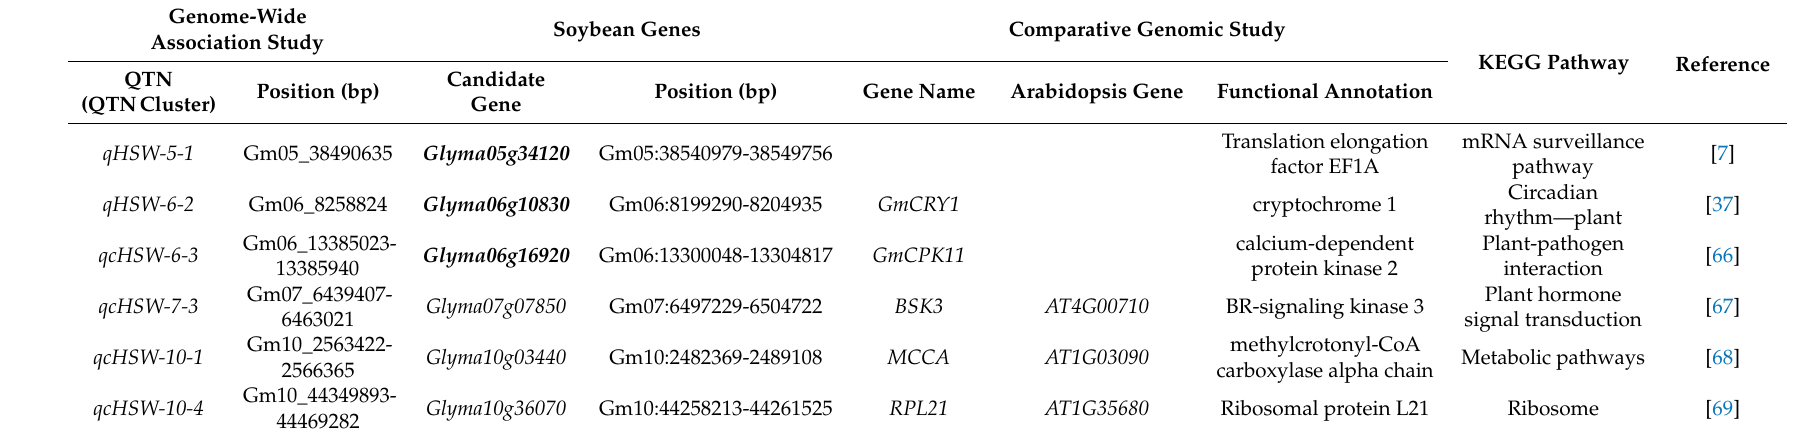
Table 5. Predicted potential candidate genes for 100-seed weight near the stable QTNs in